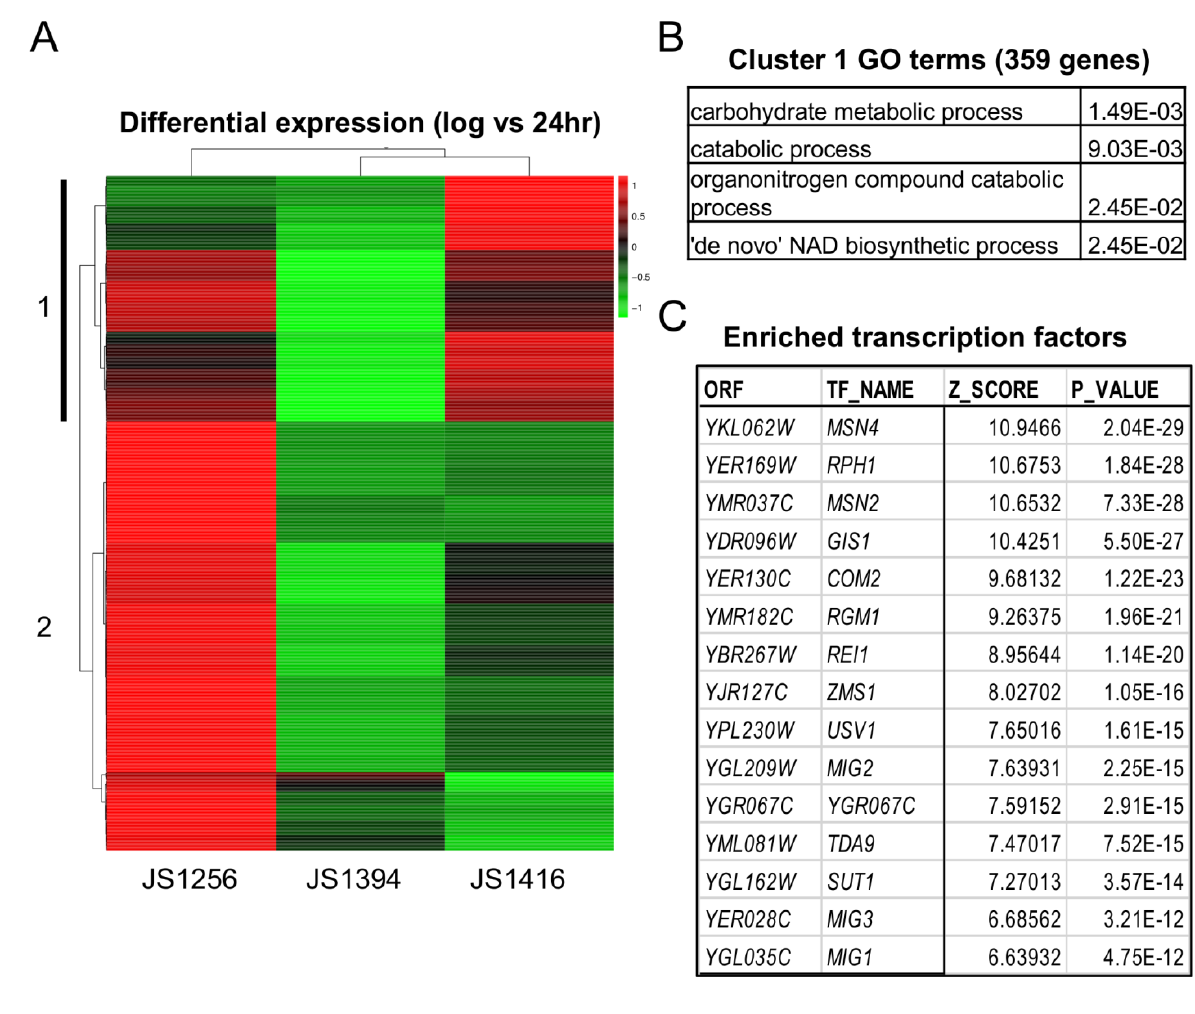
FIGURE 6: RNA-seq analysis of gene expression in WT, snf1 ∆, and bypass suppressor strains. (A) Genes (986) that were upregulated at 24 hr in the WT strain (JS1256), but not in the snf1∆ strain (JS1394) were analyzed by Pearson correlation clustering and displayed as a heat map of Z-score from the mean of all three strains. Cluster 1 (vertical black bar) represents 359 genes in which expression was restored in JS1416 compared to JS1394. (B) Gene ontology (GO) terms and p-values associated with cluster 1 using Holm-Bonferroni correction. (C) Top 15 enriched transcription factors on the promoters of genes with >2-fold enrichment in JS1416 compared to JS1394 (from Supplemental Table